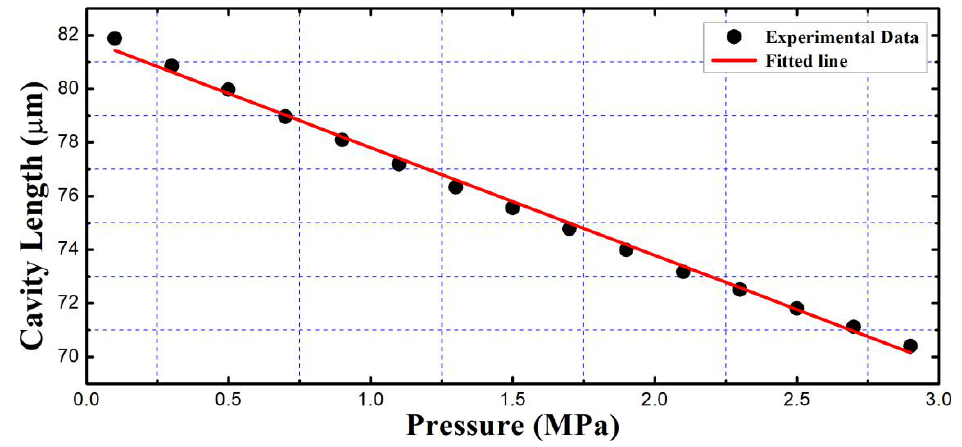
Figure 9. Relationship between air cavity length and pressure imposed.